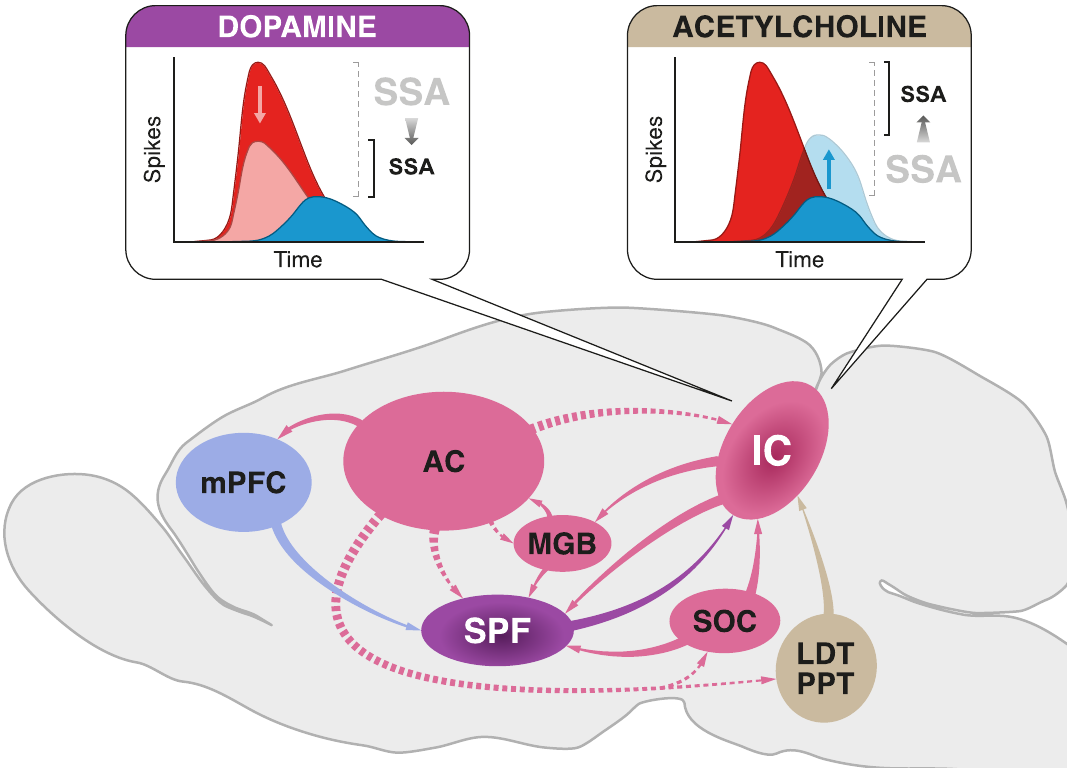
Fig 6. SPF auditory afferences. Schematic diagram of the main connections involved in SSA modulation and PE precision-weighting in the IC. The auditory pathway (in pink) is composed of ascending (solid arrows) and descending connections (dashed arrows) between cortical and subcortical auditory structures. The hierarchical exchange of bottom-up PEs and top-down predictions postulated by the predictive coding framework could be extended to subcortical auditory neurons by means of these feedback loops. The SPF (purple) receives input from main auditory nuclei (pink) and from the mPFC (violet), integrating information from manifold hierarchical processing levels. Such connectivity could allow SPF dopaminergic neurons to estimate the volatility of the probabilistic structure of the auditory context. In turn, the SPF sends dopaminergic projections back to the IC to signal the expected precision of PE signaling at low processing levels. Dopamine release in the nonlemnical IC reduces the postsynaptic responses to surprising stimuli (red) but has no effect on repetitive ones (blue), consequently reducing SSA indices. By contrast, cholinergic modulation from the LDT and PPT nuclei (brown) of the brainstem increases the responses to repetitive stimuli in the IC [65]. Note that the net effect of both dopamine and acetylcholine is the reduction of SSA indices, decreasing the relative saliency of surprising input through complementary means. AC, auditory cortex; CAS, cascade sequence; IC, inferior colliculus; LDT, laterodorsal tegmental; MGB, medial geniculate body; mPFC, medial prefrontal cortex; PE, prediction error; PPT, pedunculopontine tegmental; SOC, superior olivary complex; SPF, subparafascicular nucleus of the thalamus; SSA, stimulus-specific